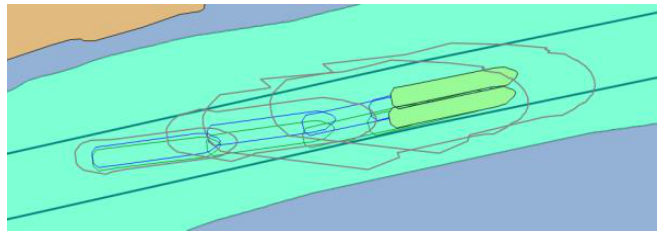
Figure 17. Changes in MVPA size resulting from GNSS signal deterioration.